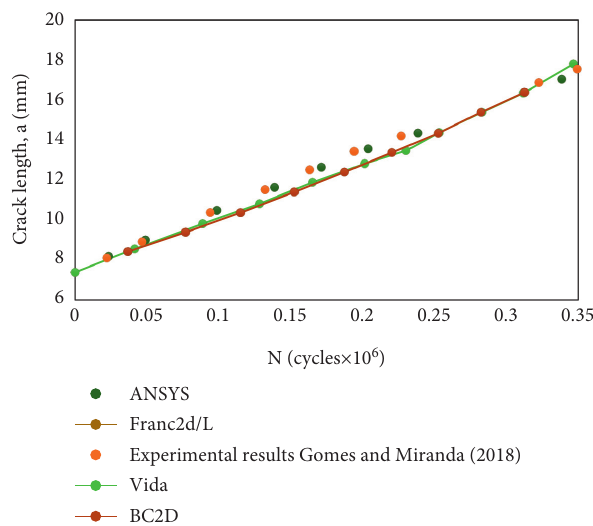
Figure 18: Comparison of the fatigue life and cracks length for the CTS02 specimen.